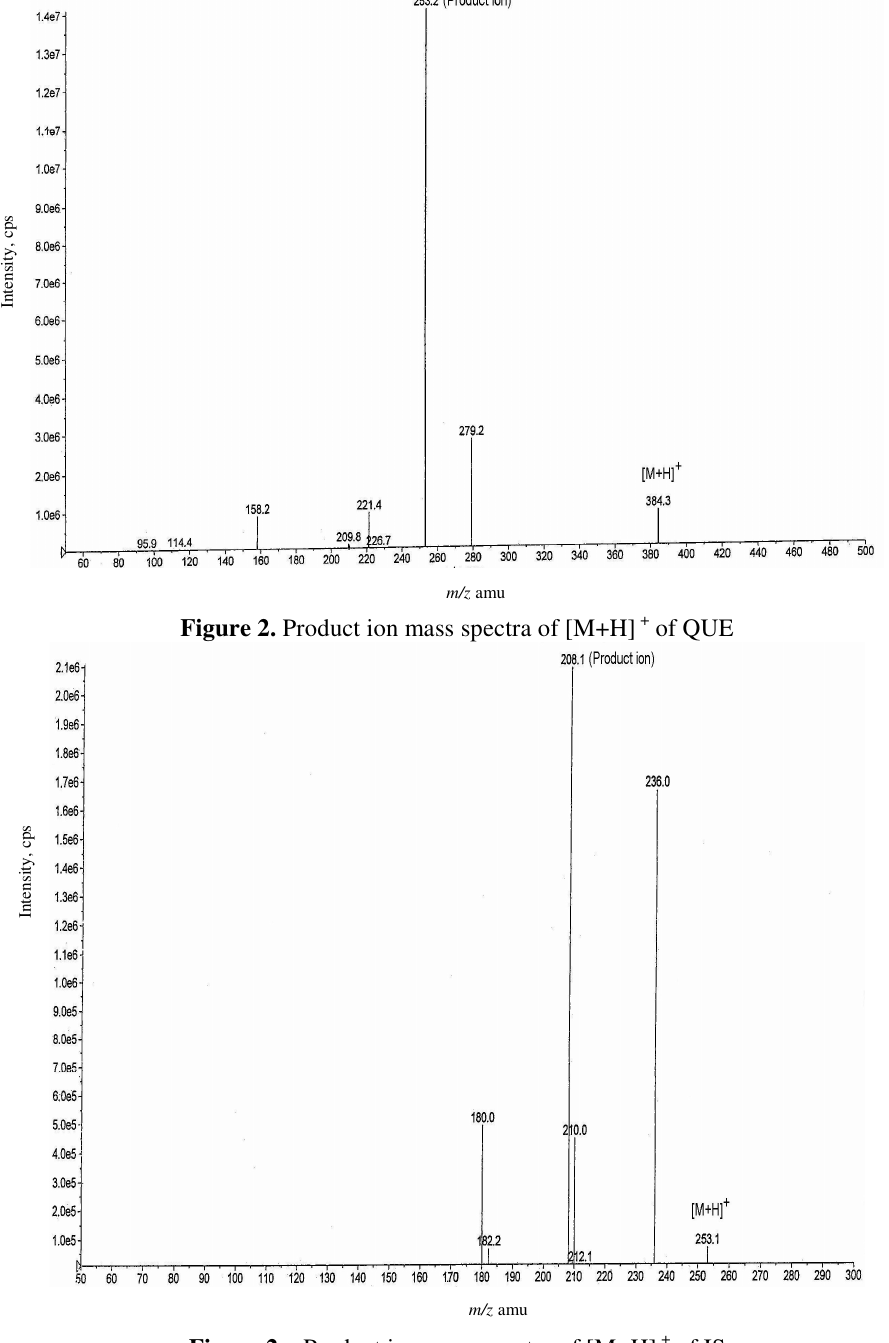
Figure 2. Product ion mass spectra of [M+H] + of QUE